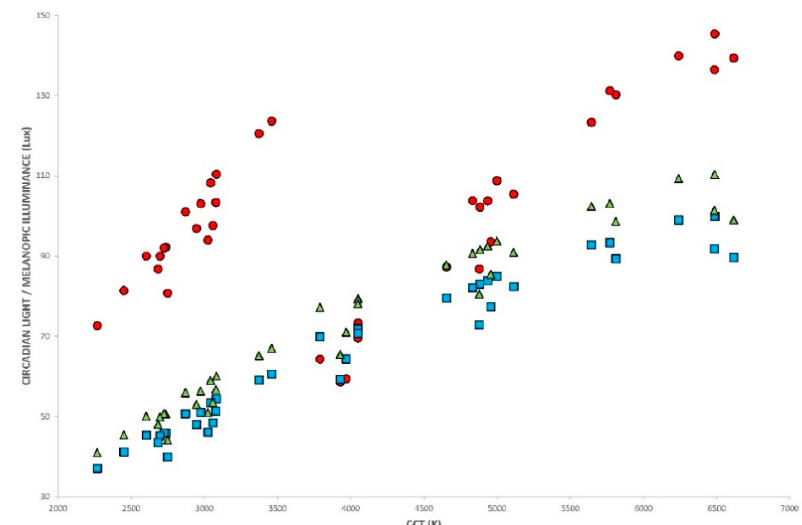
Figure 2. CL A , circadian light; (cid:3) CIE (EDI) and ∆ WELL(EML), melanopic illuminance as a function (cid:35) of the CCT. Figure 2. ○ CL A , circadian light; □ CIE (EDI) and Δ WELL(EML), melanopic illuminance as a function of the CCT.